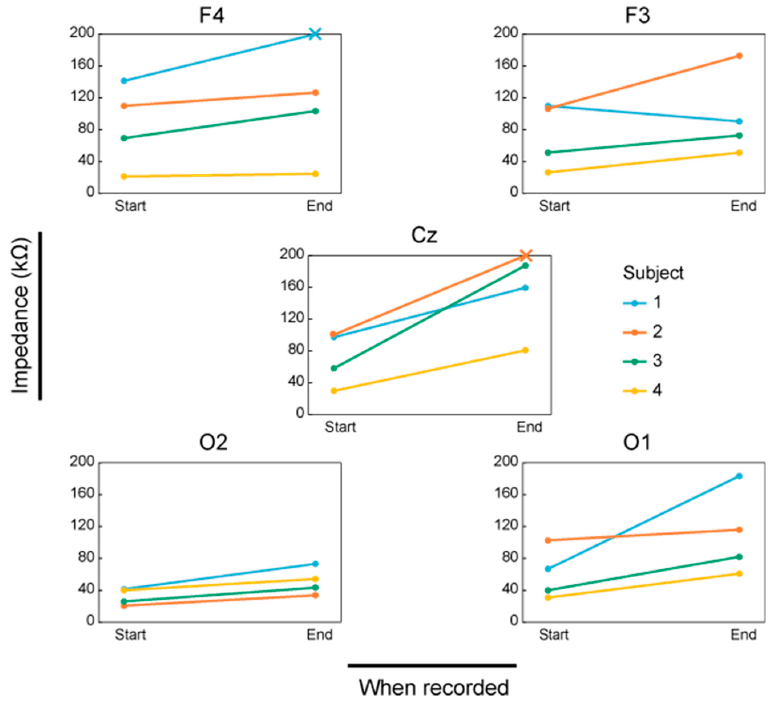
Figure 12. The scalp–electrode impedance of each channel at the beginning and the end of the measurement. An × mark shows an impedance of above 200 k Ω .